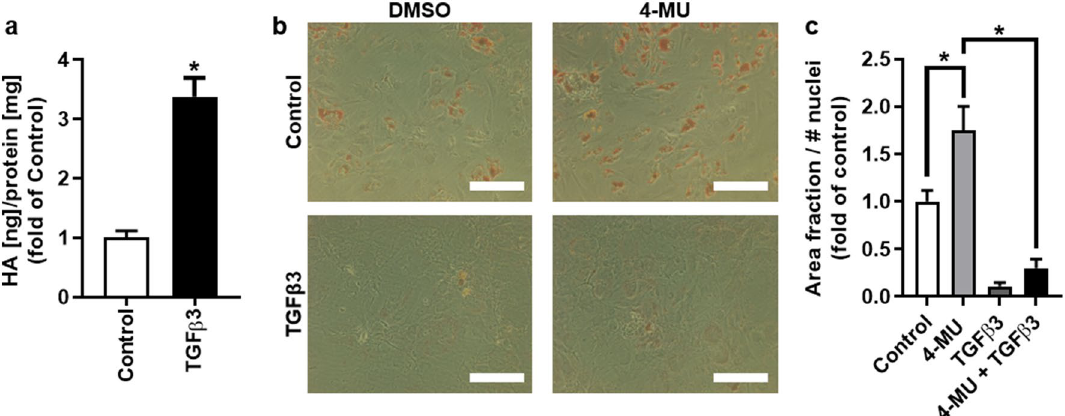
Figure 4. TGFβ3 increases HA-synthesis in bmMSCs and modulates adipogenic differentiation ( a ) bmMSCs were treated with TGFβ3 (5 ng/ml) and the amount of secreted HA was analysed with an ELISA-like HABP- binding assay after 48 h. The results were normalised to the protein content of the cell lysates. n = 4. Mean ± SEM. * p < 0.5 compared to control. ( b ) and ( c ) BmMSCs were differentiated into adipocytes with or without the addition of 4-MU (300 µM) or TGFβ3 (5 ng/ml) over a period of 28 days. ( b ) Lipid vesicles of adipogenic differentiated bmMSCs were stained with Oil Red O. Scale bar = 200 µm. ( c ) Adipogenic differentiation was quantified by determining the area fraction of Oil Red O-stained lipid vesicles and normalised to the number of nuclei. * p < 0.05. n = 4. Mean ± SEM. This figure was prepared with GraphPad Prism (v9.2.0.332, www. graph pad.